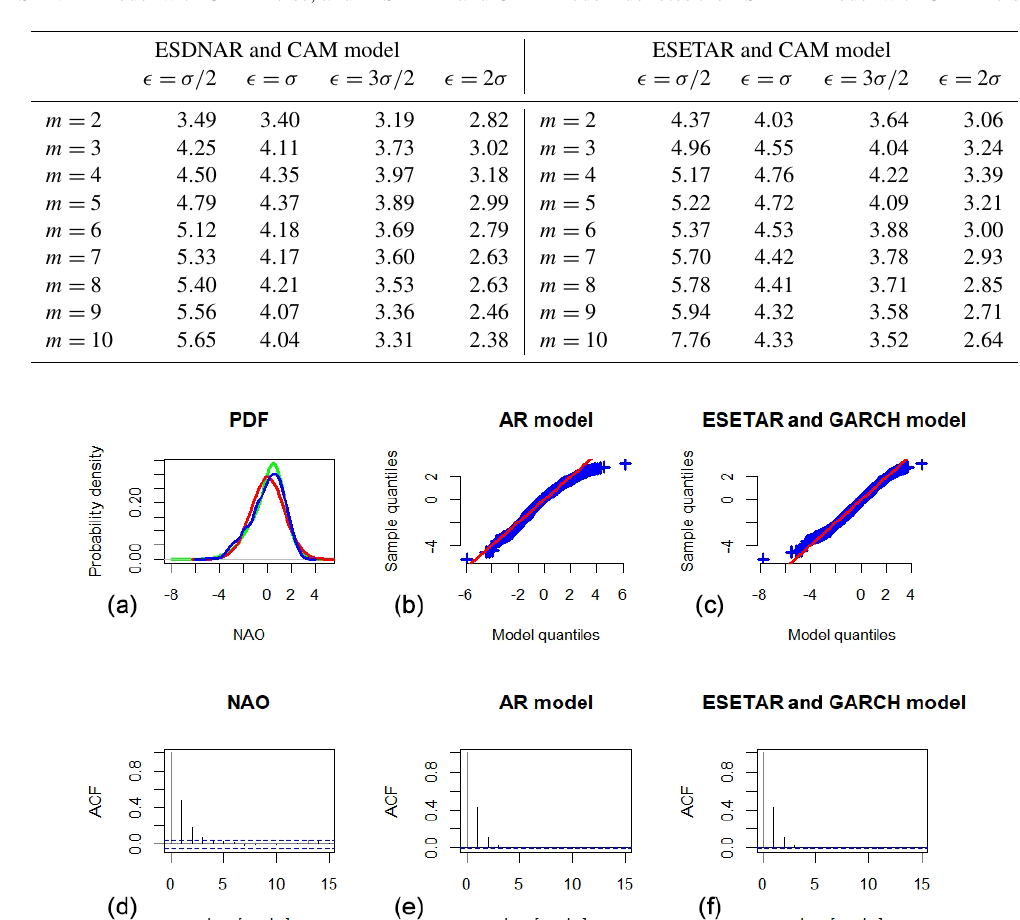
Table 7. BDS test results for the standardized residuals of the CAM noise models. The test has been performed with parameter values m ∈ { 2 ,..., 10 } and (cid:15) ∈ { 1 / 2 , 1 , 3 / 2 , 2 } σ , where σ is the sample standard deviation of the residuals. Note: “ESDNAR and CAM model” denotes the ESDNAR model with CAM noise, and “ESETAR and CAM model” denotes the ESETAR model with CAM noise.